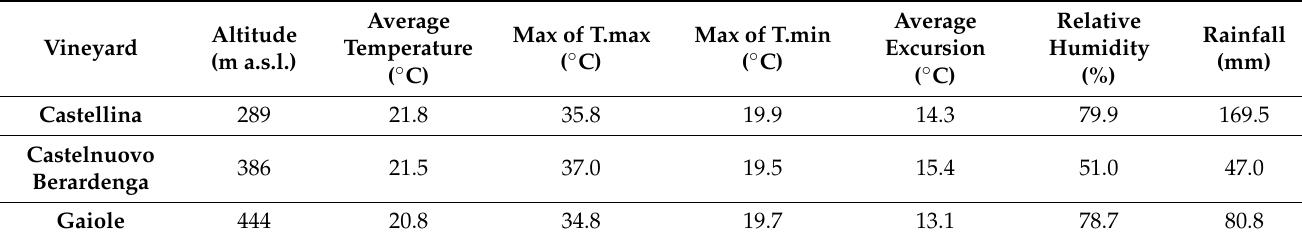
Table 4. The climate parameters (average temperature ( ◦ C), average excursion ( ◦ C), max of the maximum temperature and minimum temperature ( ◦ C), rainfall (mm) and relative humidity (%)) that were recorded in the areas under investigation and the altitude of the